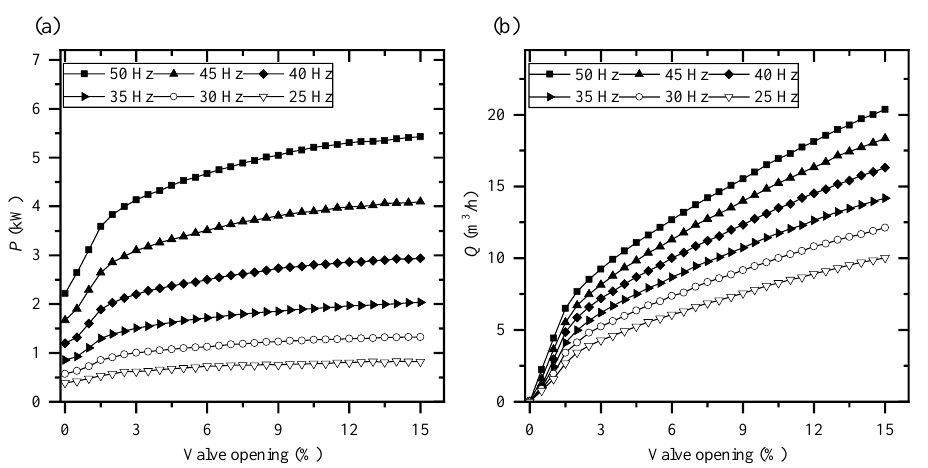
Figure 4. Shaft power and flow variation with valve opening: ( a ) shaft power and ( b ) flow rate.